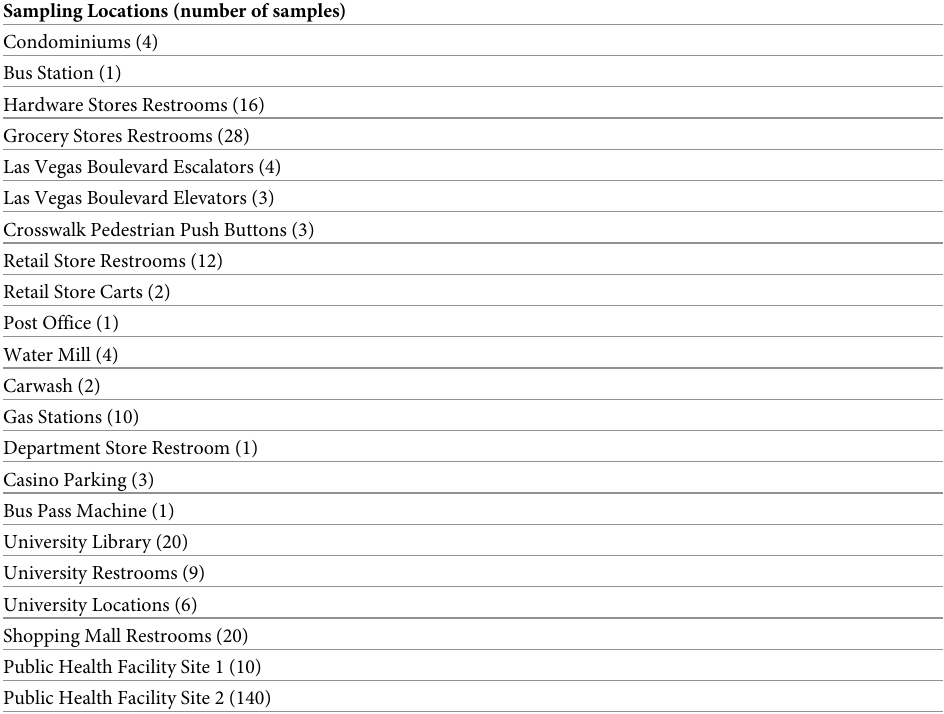
Table 1. Sampling